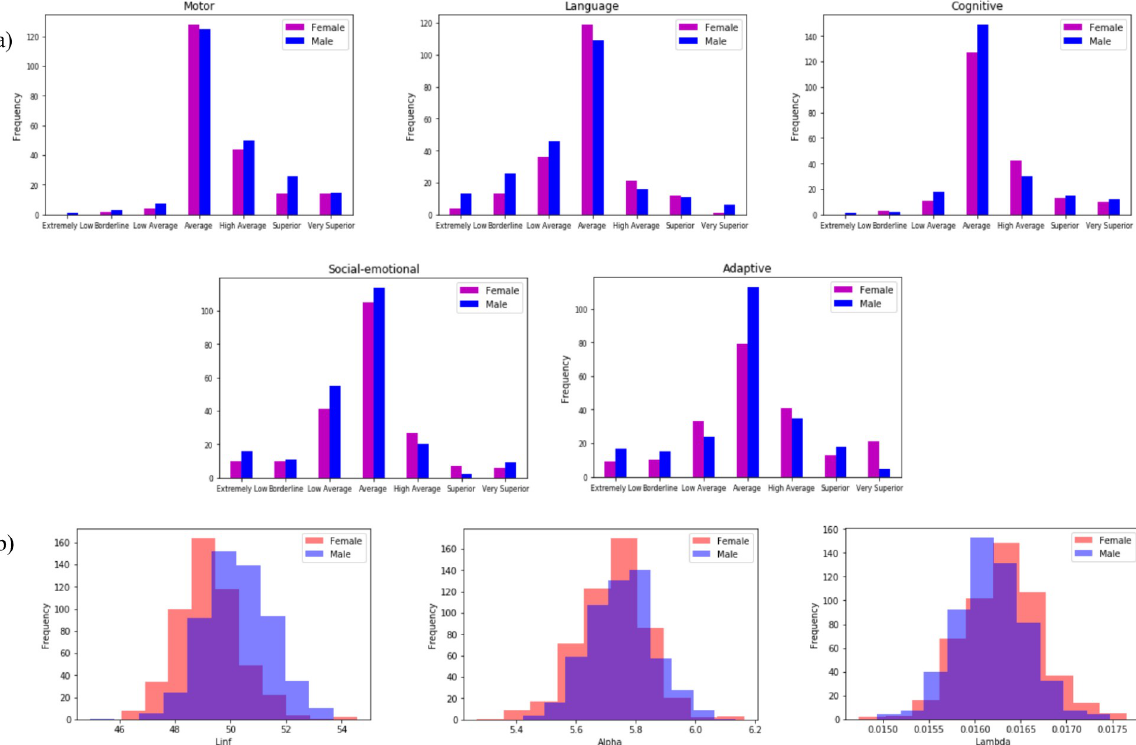
Fig 12. Distribution of SNPs in the X and Y region for Bayley’s and growth phenotypes. a ) The distributions of Bayley phenotypes by male and female infants used for the two-variable < Bayley, SNPs > analysis. b ) The distributions of Growth phenotypes by male and female infants used for the two-variable < Growth, SNPs >